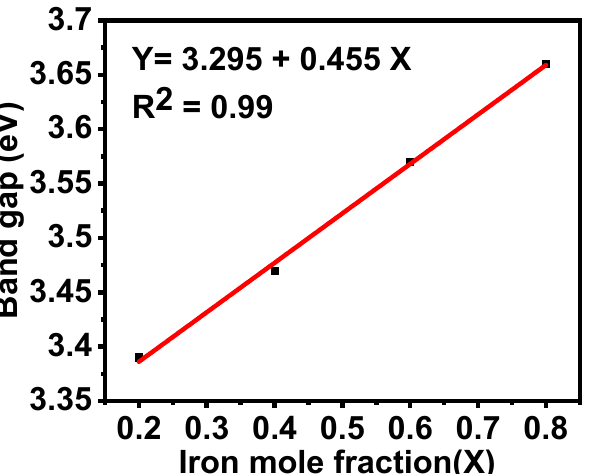
Figure 7. Variation of the direct band gaps for Sb 2(1– x ) Fe 2 x S 3 (0 ≤ x ≤ 1) samples prepared at different mole fractions of x = 0.2, 0.4, 0.6, and 0.8.